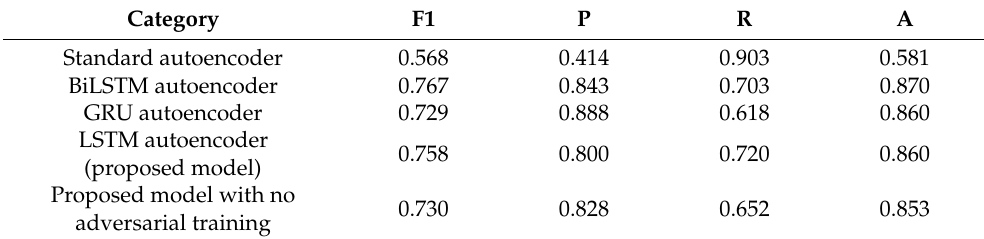
Table 10. Performance comparison of LSTM autoencoder with